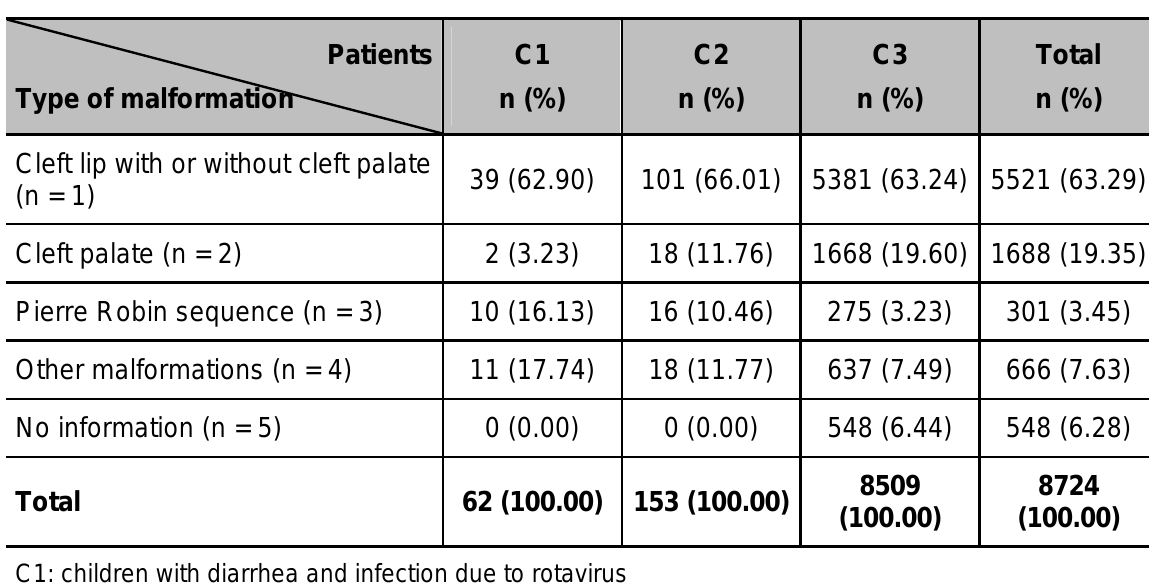
Table 3. Distribution of the 8,724 children with craniofacial malformations of groups C1, C2 and C3 according to the type of craniofacial